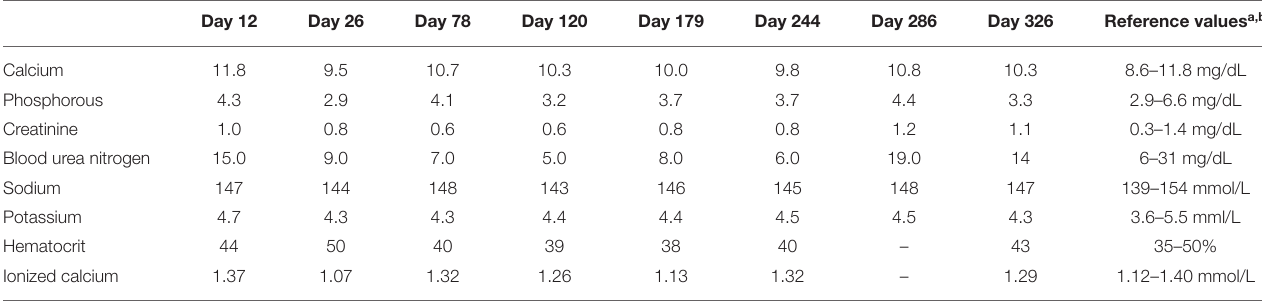
TABLE 2 | Serial serum biochemical parameters, ionized calcium concentration, and hematocrit in a dog with cholecalciferol rodenticide toxicosis during the chronic phase starting at the first recheck after hospital discharge (day 12) until the day